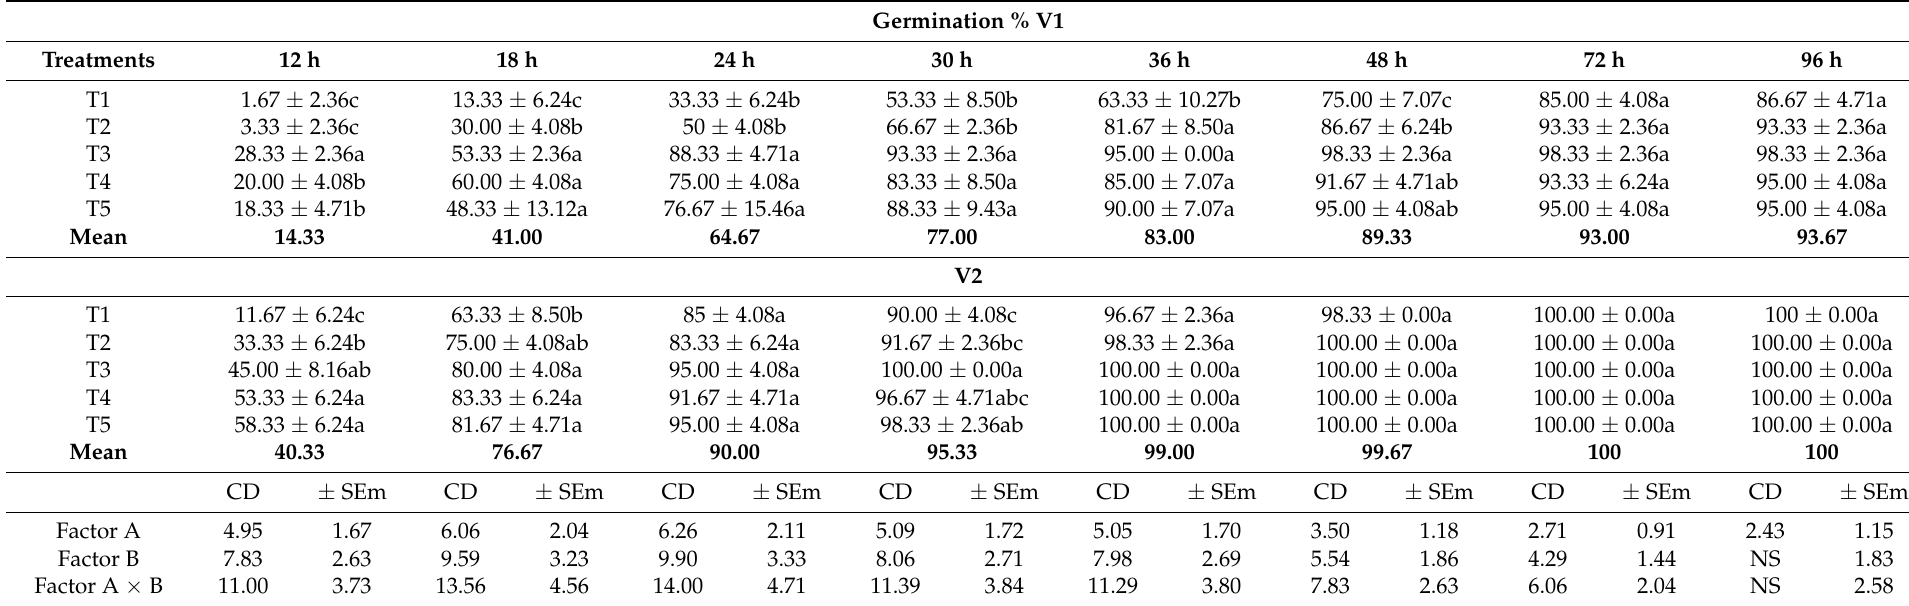
Table 1. Germination of wheat varieties under different priming